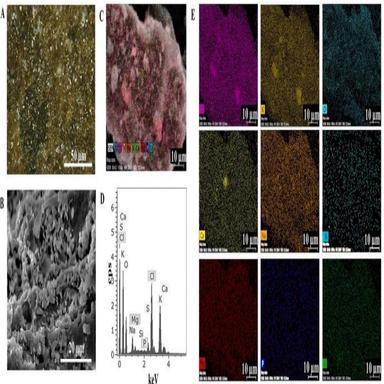
Ecklonia radiata topographical and compositional characterization of raw sample surface at different magnifications. A) 3D confocal laser-scanning microscopic image revealing distinctive halide clusters on the particle surface as result of the micronization method. B) SEM micrograph of the morphological features of the diverse halide crystals. C) SEM/EDS qualitative map of elements. D) Elemental spectral data. E) Individual map of elements at high-magnification.